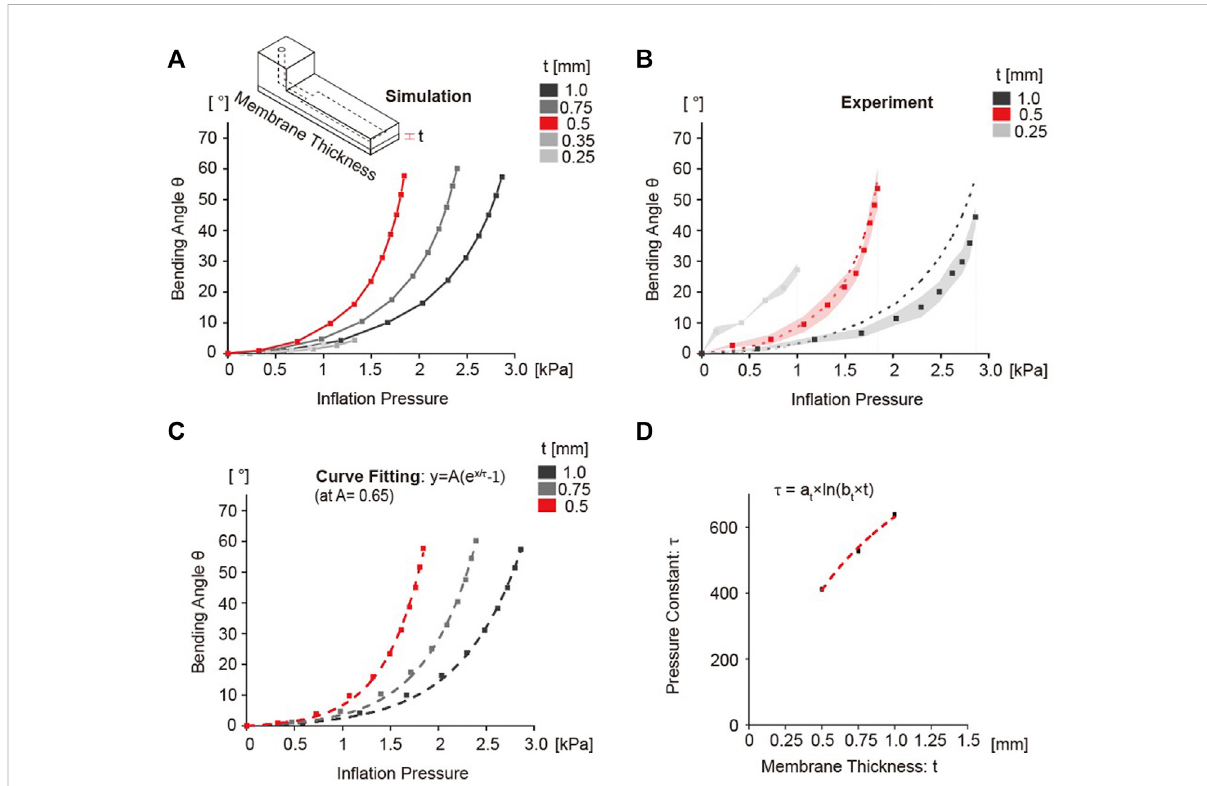
FIGURE 4 Simulationandexperimentalresultsofbendingangleasafunctionofmembranethickness. (A) Simulationgraphshowingthebendingangleasa function of in fl ation pressure change. The difference in the bending angle was con fi rmed by gradually increasing the membrane thickness from 0.25 to 1.0 mm. 0.5 mm curve shown in red wasconsidered thestandard control condition. (B) Experimental results ofbending angle with 0.25, 0.5, 1.0 mm.Dotsindicatestheaveragevaluesofbending angle, andtheshadedarearepresented thestandarddeviationofeachdatapoint. Dotted lines are the simulation results from (A) . (C) Curve fi tting analysis results using the exponential growth model. The dashed line indicates the fi tting curve graph using estimated variables. (D) Change of pressure constant τ according to change in membrane thickness. The constant τ showed a logarithmically increasing relationship with membrane thickness.